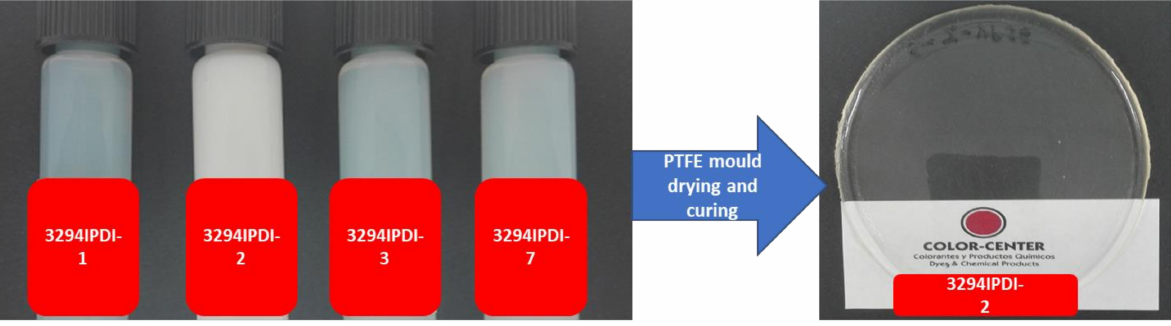
Figure 6. Appearance of the synthesized WPUD ( left ) and appearance of casted film from one of the polyurethane-urea dispersions (3294IPDI-2, right